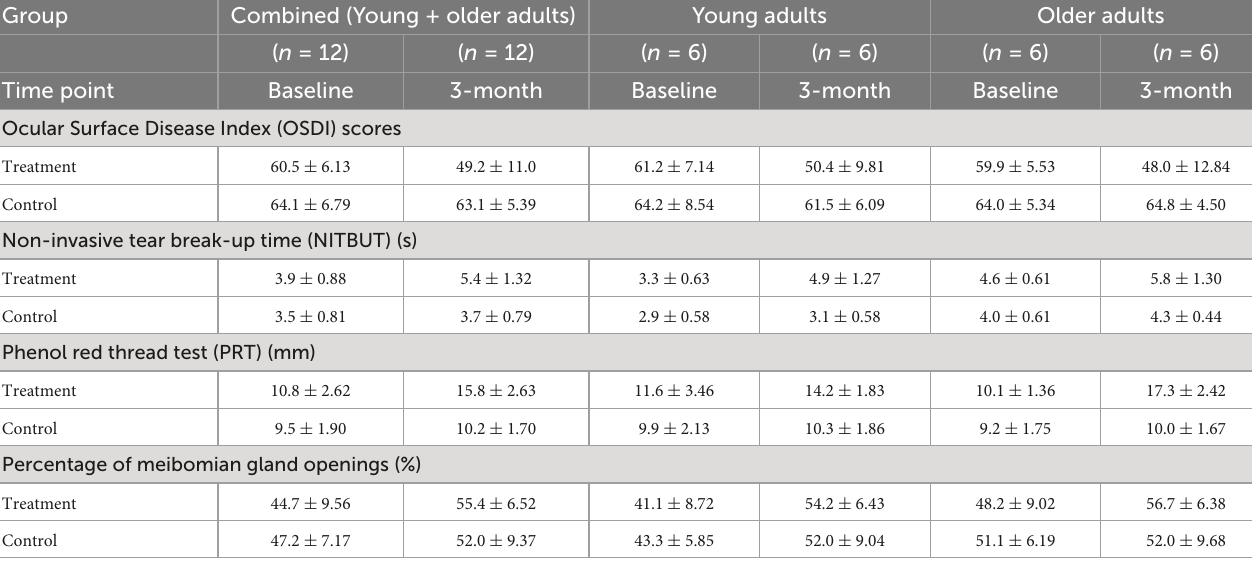
TABLE 3 Dry eye disease characteristics of participants at baseline and 3-month follow-up.